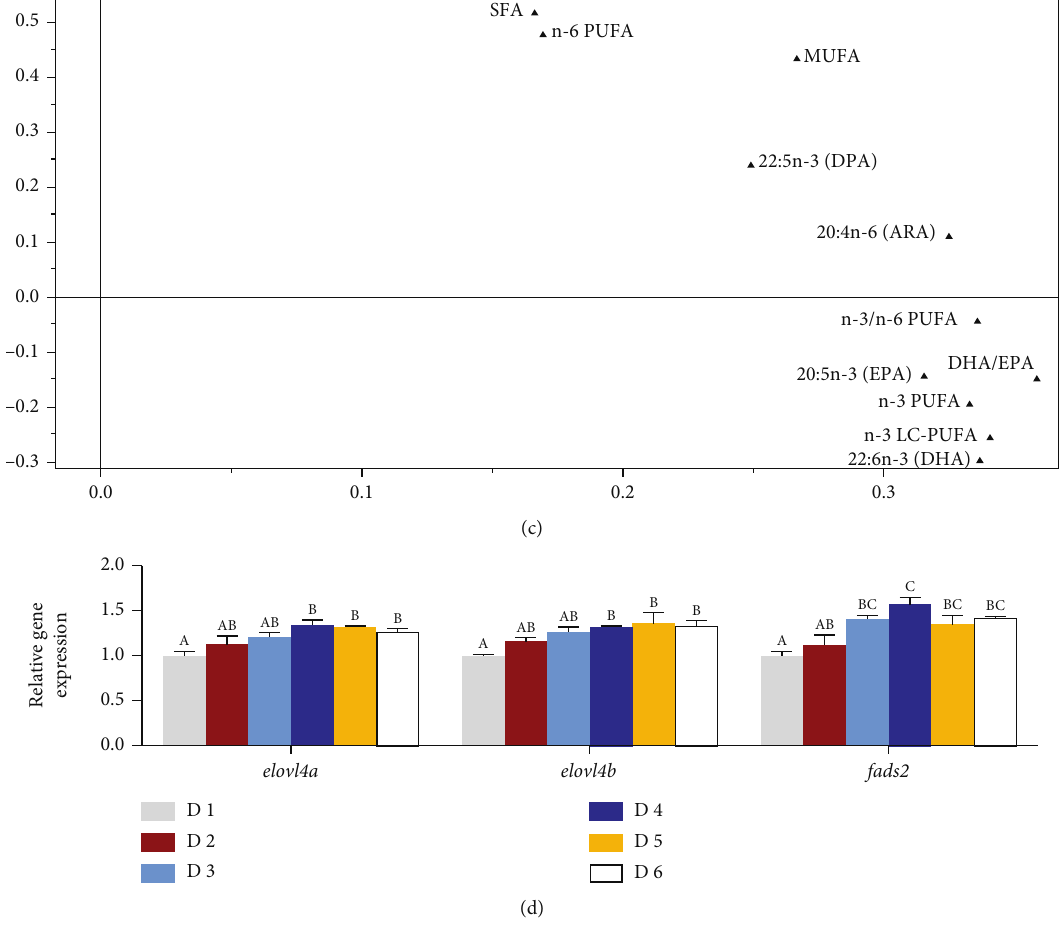
Figure 3: E ff ects of dietary lipid levels, fatty acid pro fi les, and LC-PUFA biosynthesis in the liver of juvenile Acanthopagrus schlegelii reared at low-salinity water. Heat map visualization of hepatic fatty acid composition (a), principal component analysis score plot (b), loading plot (c), and the expression levels of genes involved in LC-PUFA biosynthetic pathway (d). The expression levels of target gene were calculated relative to the expression level of β -actin and then presented as relative to the expression level in the D1 group. Values are means ( n = 3 ), with standard errors represented by vertical bars. Mean values for the same column with di ff erent superscript letters were signi fi cantly di ff erent ( P < 0 : 05 ). ARA: 20:4n-6; DHA: 22:6n-3; DHA/EPA: 22:6n-3/20:5n-3; elovl4a : elongase of very long chain fatty acids 4a; elovl4b : elongase of very long chain fatty acids 4b; EPA: 20:5n-3; fads2 : fatty acyl desaturase 2; LC-PUFA: long-chain polyunsaturated fatty